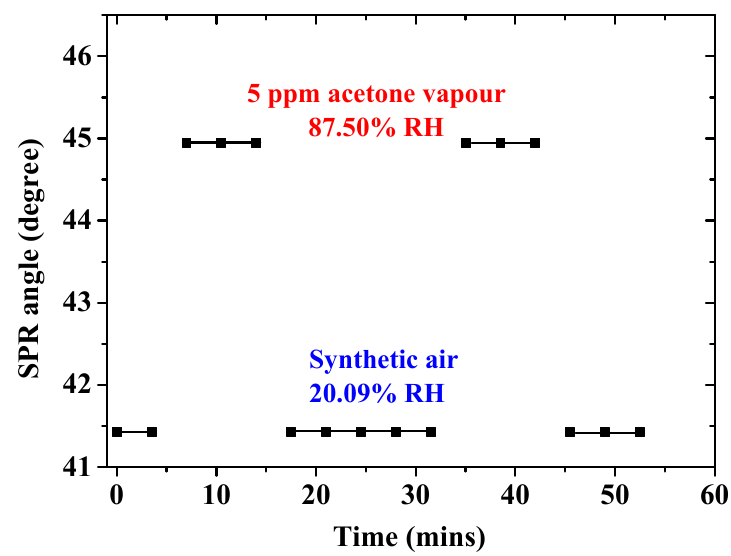
Figure 8. SPR angle versus time of the single-layer chitosan-PEG-based SPR sensor at 5 ppm acetone vapor concentration as compared to synthetic air levels.